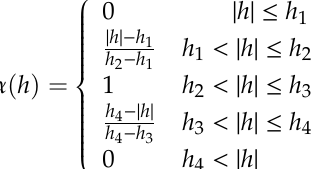
Figure 5. Schematic image of root distribution (modified from [66]).